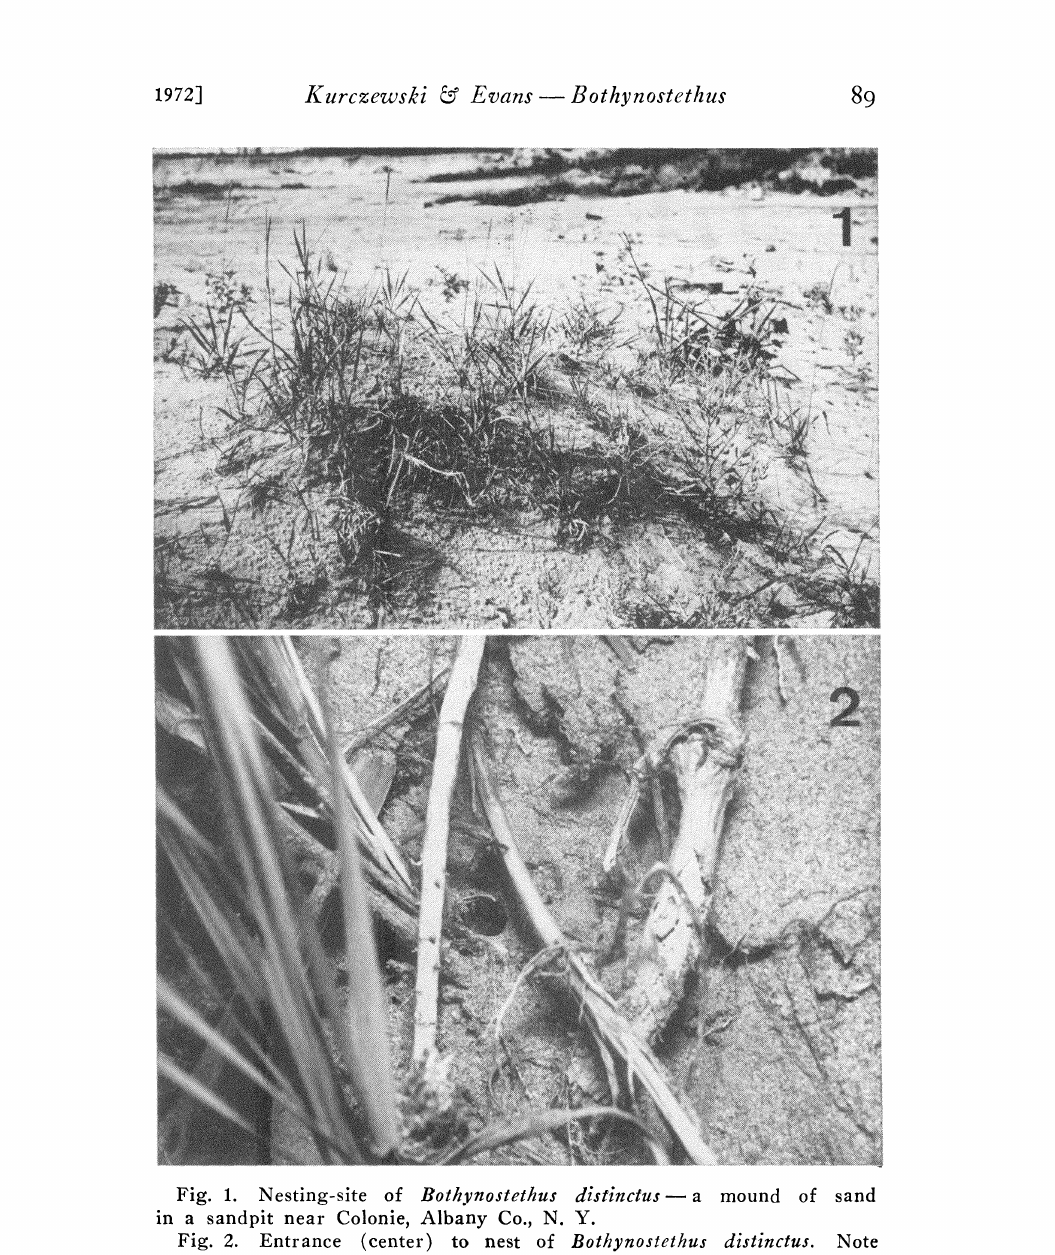
Fig. 1. Nesting-site of Bothynostethus distinctusma mound of sand in a sandpit near Colonic, Albany Co., N. Y. Fig. 2. Entrance (center) to nest of Bothynostethus distinctus. Note surrounding rootlets and grass